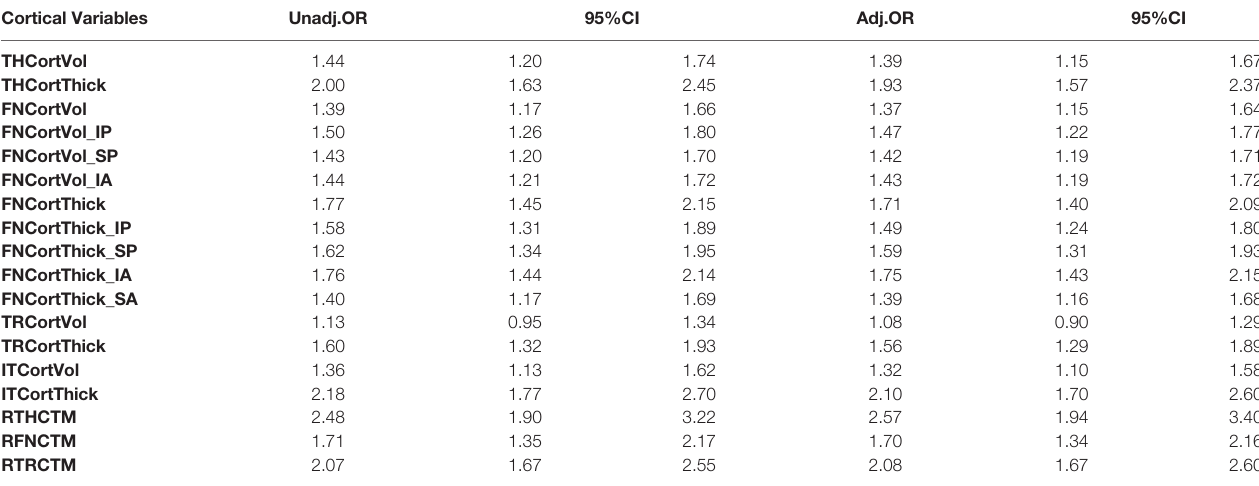
TABLE 2 | Associations of cortical volume and thickness with hip fracture. Cortical Variables Unadj.OR 95%CI Adj.OR 95%CI THCortVol